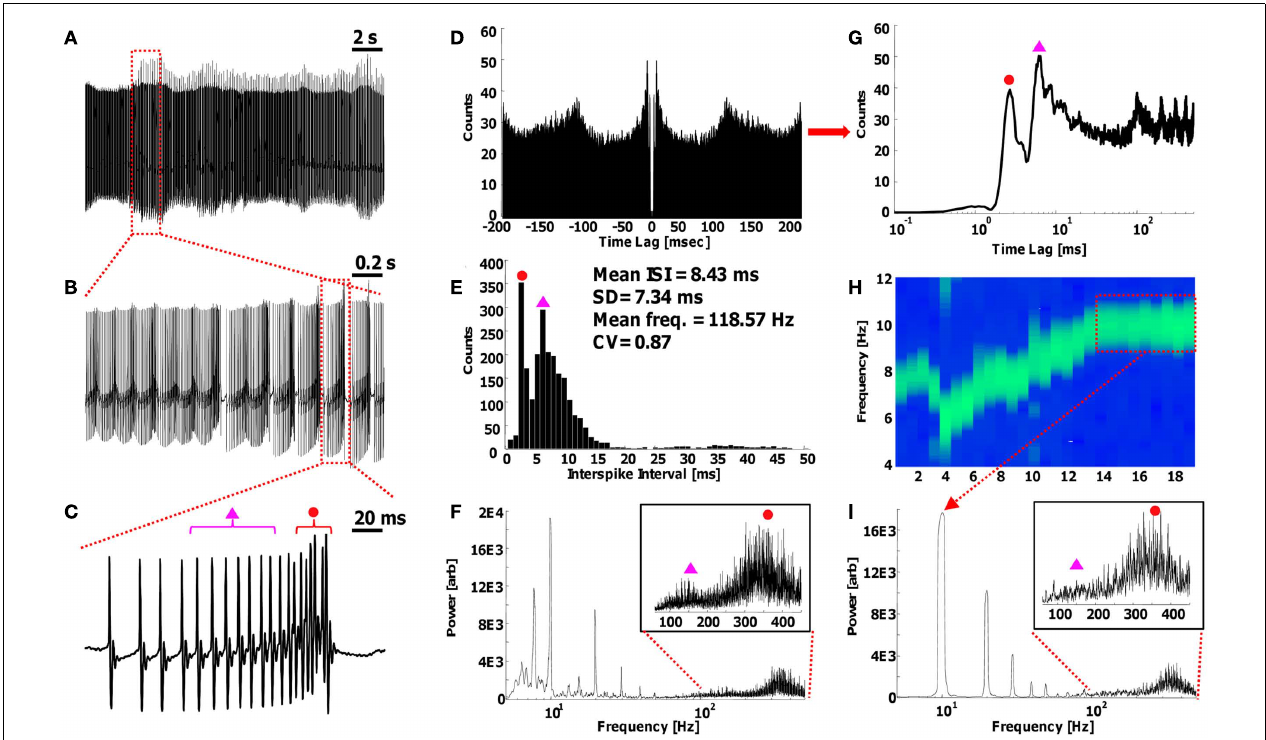
FIGURE 2 | Comparing analysis methods on a segment of Purkinje output signal. (A) Twenty seconds recording of a Purkinje neuron induced into firing Ca 2 + spikes (Abrams et al., 2010). (B) Close-up of a 2s frequency transition period. (C) Close-up of a single Ca 2 + spike (small underlying upward curve), with Na + spikes riding on top (large action potential spikes).The Na + spikes are frequency modulated – chirped – their frequency goes up with the amplitude of the Ca 2 + spike. (D) Standard autocorrelogram, and (E) The interspike interval (ISI) of the full 20s signal in (A) , as traditionally displayed.The autocorrelogram in this form only provides minimal information of the shortest spike times, being the peaks near time lag = 0.The ISI displays two peaks, with a mean of 8.4ms ( = 118Hz).The individual peaks are at 2.7ms (red dot) and 6.7ms (magenta triangle).The CV is the noise (SD) over the mean, the reciprocal of the signal-to-noise ratio (SNR). (F) Full FT of (A) low-frequency Ca 2 + spikes at ∼ 10Hz and very high-frequency Na + spikes at 80–400Hz. Inset: the